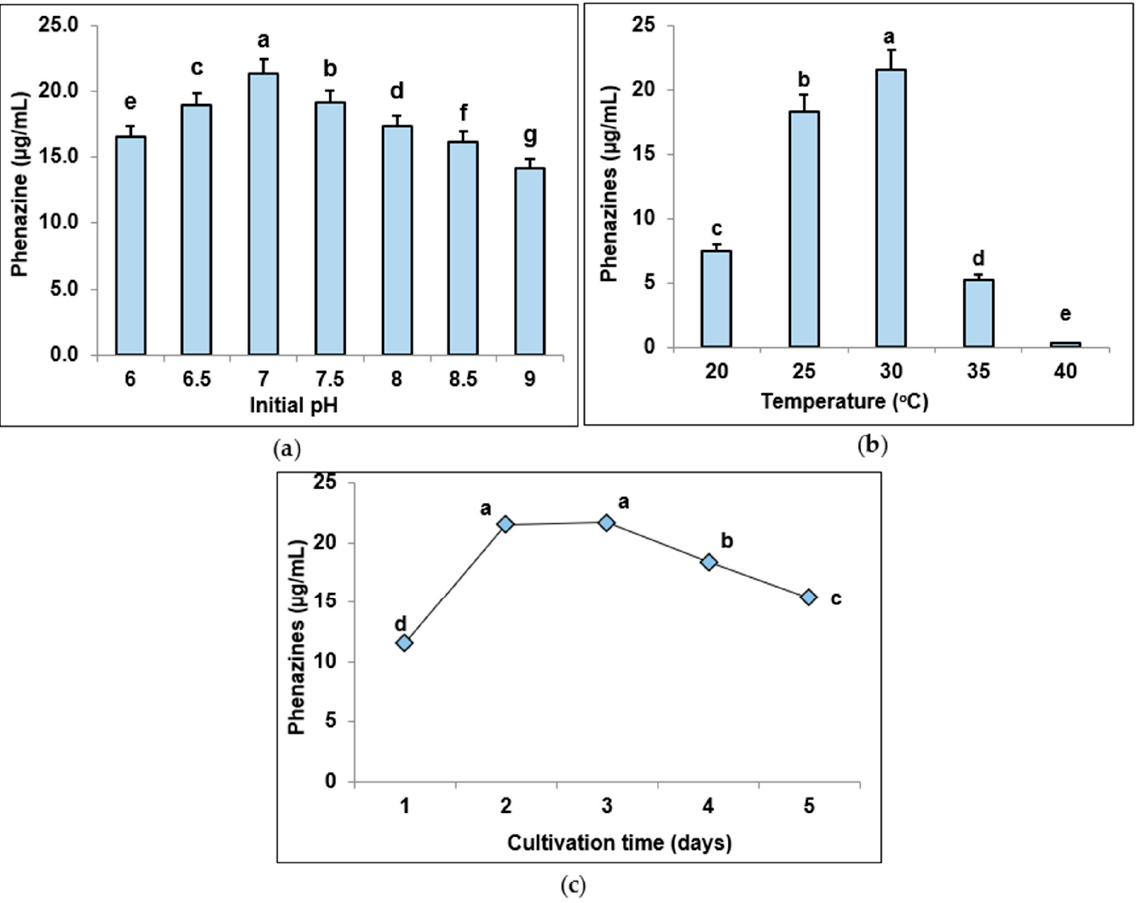
Figure 4. The effect of initial pH of culture broth ( a ), the fermentation temperature ( b ), and fermentation time ( c ) on phenazine biosynthesis by Pseudomonas aeruginosa TUN03. The different letters show a statistically significant difference. The LSD values; CV for the test of initial pH (0.0542; 0.123263, respectively), for the test of fermentation temperature (0.1108; 0.382522, respectively), and for the test of fermentation temperature (0.4742; 0.978673, respectively) are presented.